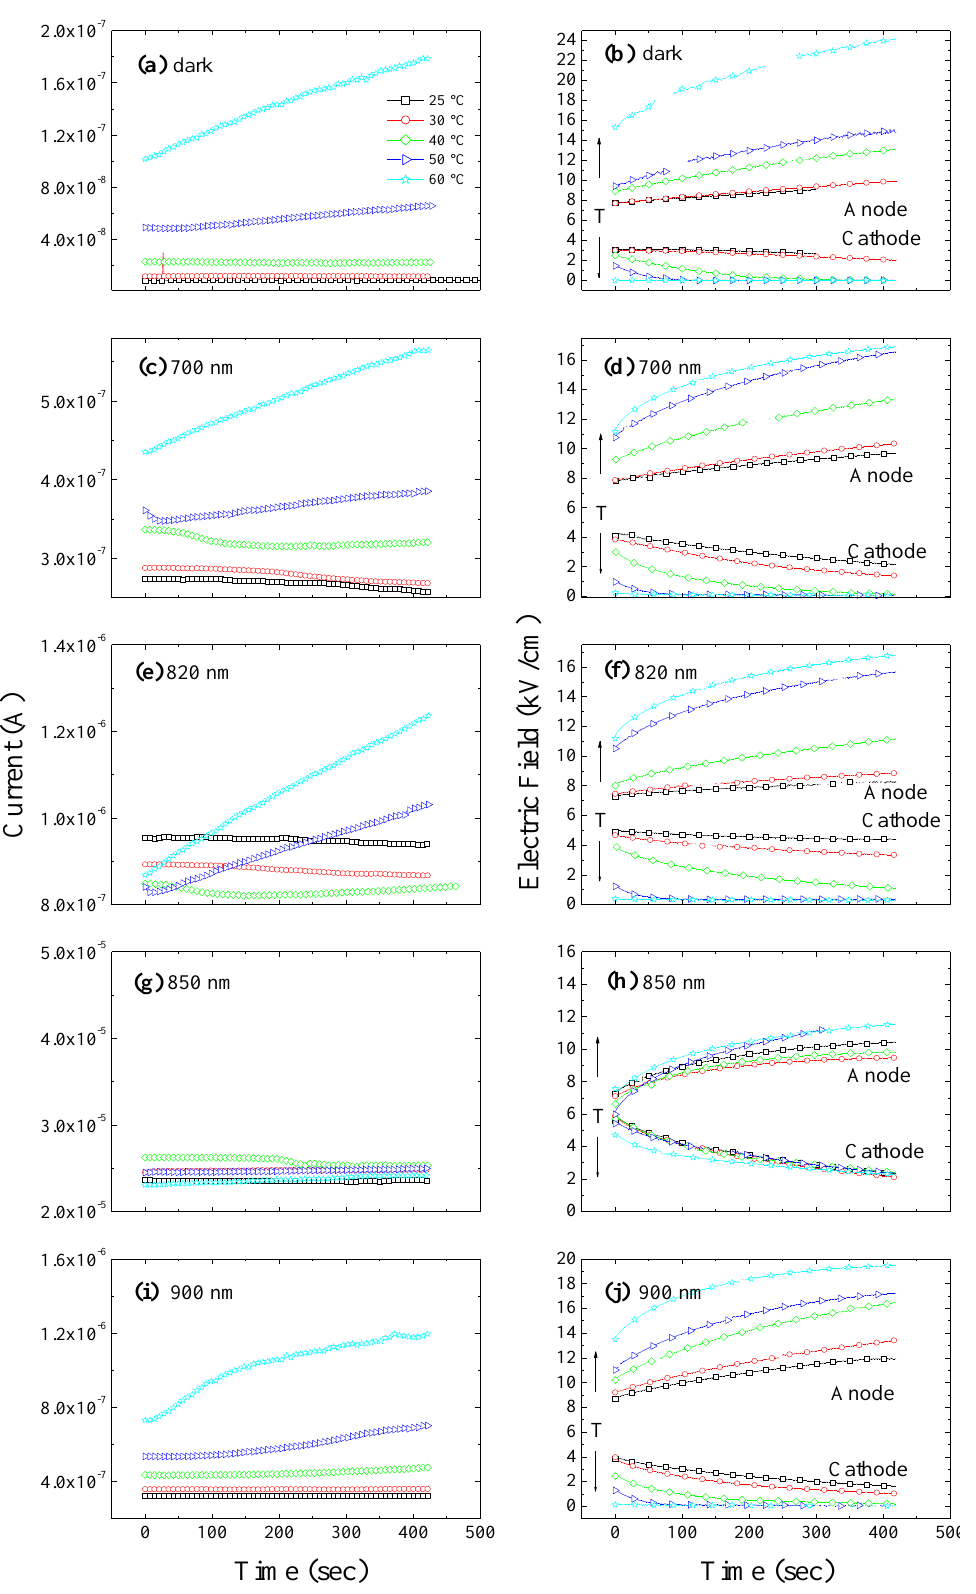
Figure 5. Transients of currents (Left) and electric fields at anode and cathode (Right) at different temperatures in perturbation-free condition ( a , b ), and under different optical irradiations on the anode side: 700 nm ( c , d ); 820 nm ( e , f ); 850nm ( g , h ); 900 nm ( i , j ). Applied voltage is 600